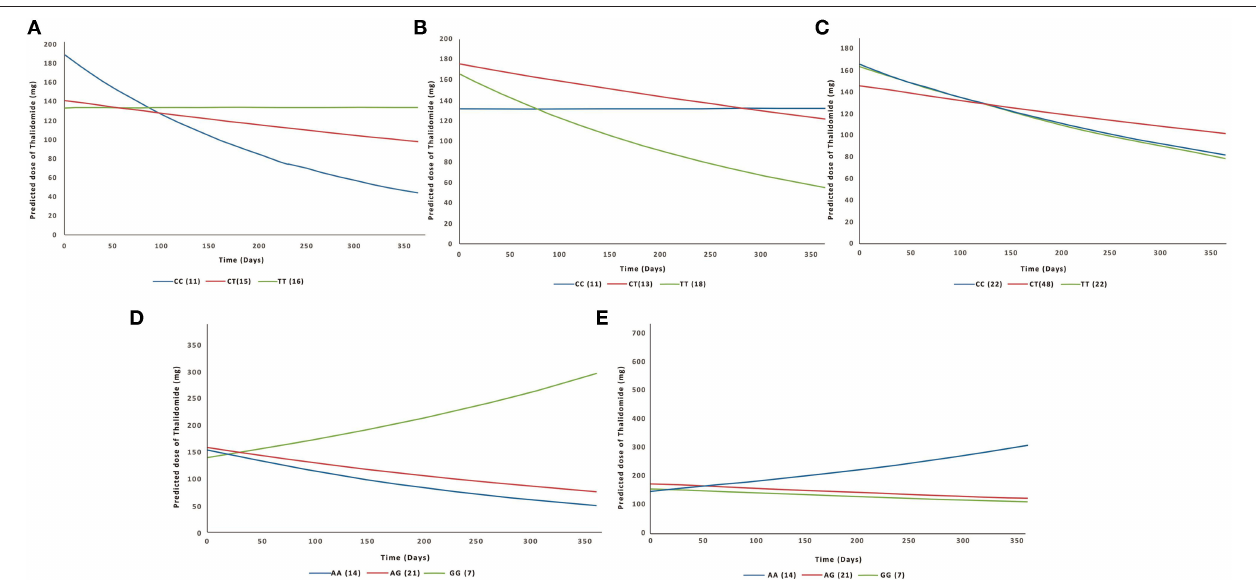
FIGURE 1 | Lines charts of the thalidomide dose averages with Toll-like receptor genotypes discriminated by the times evaluated. (A) TLR1 / rs4833095 in the South region: blue line, CC genotype; red line, CT genotype; green line, TT genotype. (B) TLR2 /rs3804099 in the South region: blue line, CC genotype; red line, CT genotype; green line, TT genotype. (C) TLR2 /rs3804099 in the Northeast region: blue line, CC genotype; red line, CT genotype; green line, TT genotype. (D) TLR4 /rs1927914 in the South region: blue line, AA genotype; red line, AG genotype; green line, GG genotype. (E) TLR6 / rs5783810 in the Northeast region: blue line, AA genotype; red line, AG genotype; green line, GG